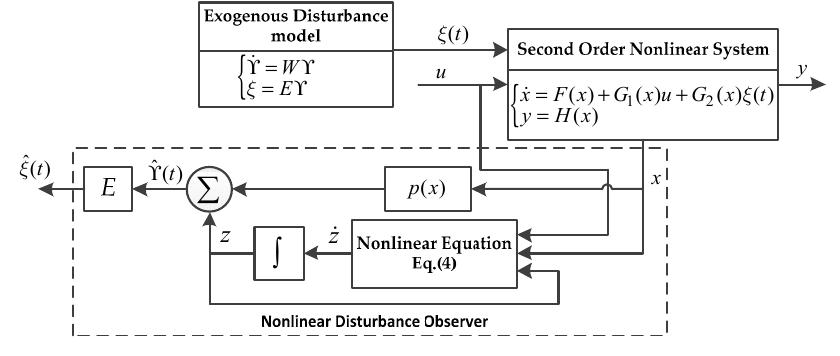
Figure 1. General structure of NDO for harmonic disturbances.